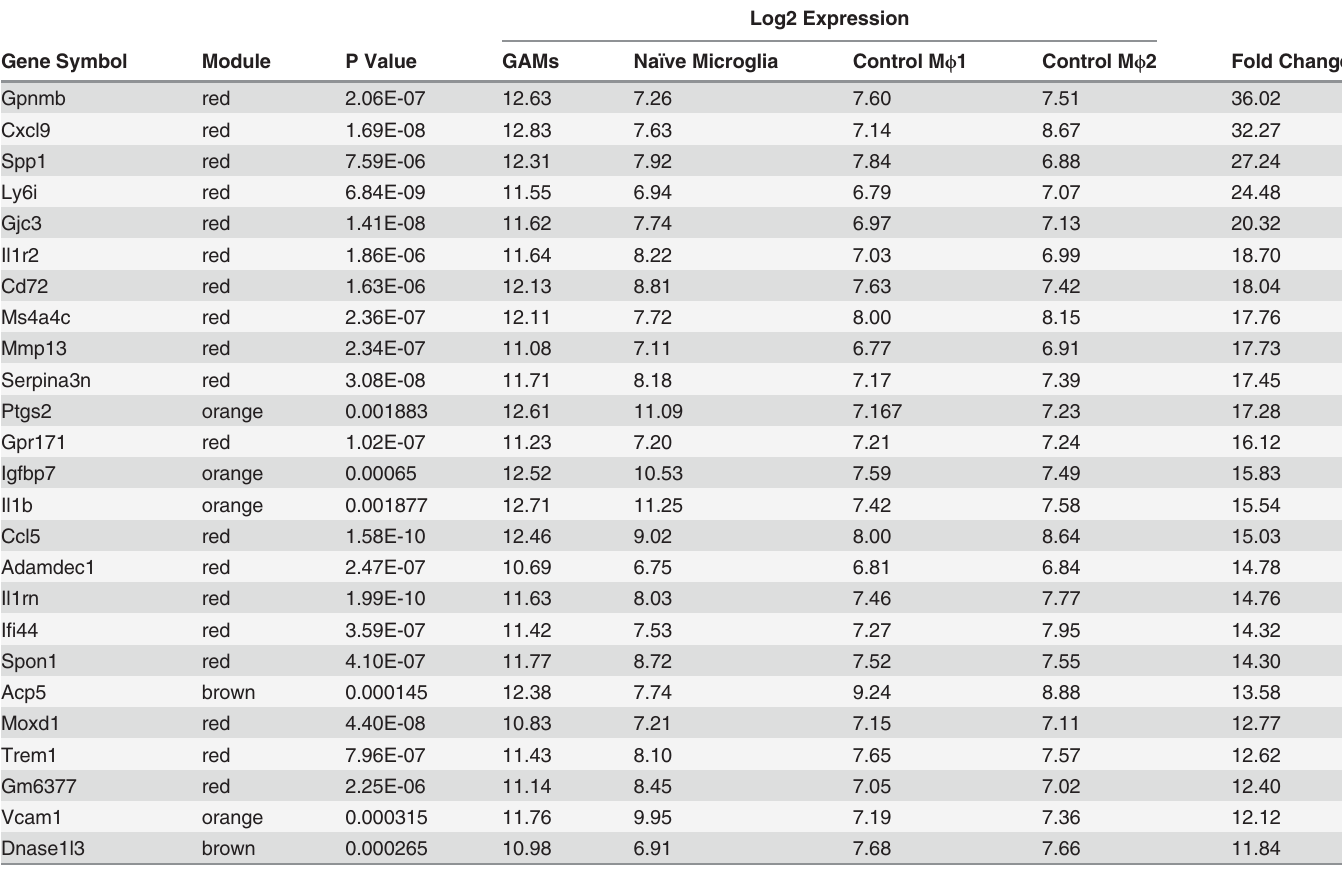
Table 1. The 25 highest-upregulated genes in the glioma-associated data set compared to all three control sets.